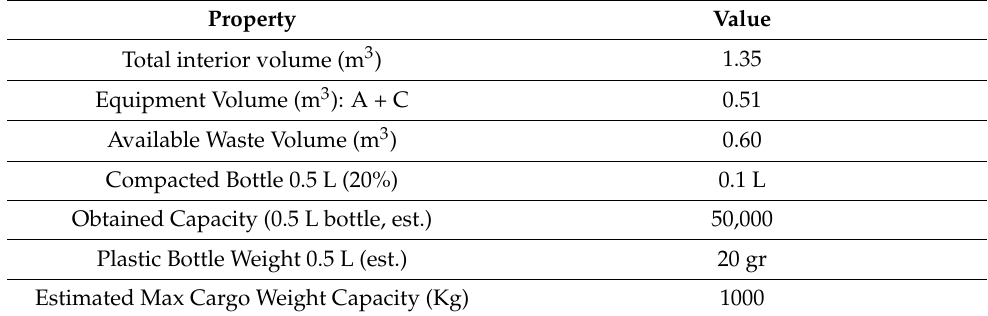
Figure 17. Aesthetic prototype of the marine drone: ( a ) during the day, ( b ) during the night. Table 6. Cargo Volume Capacity